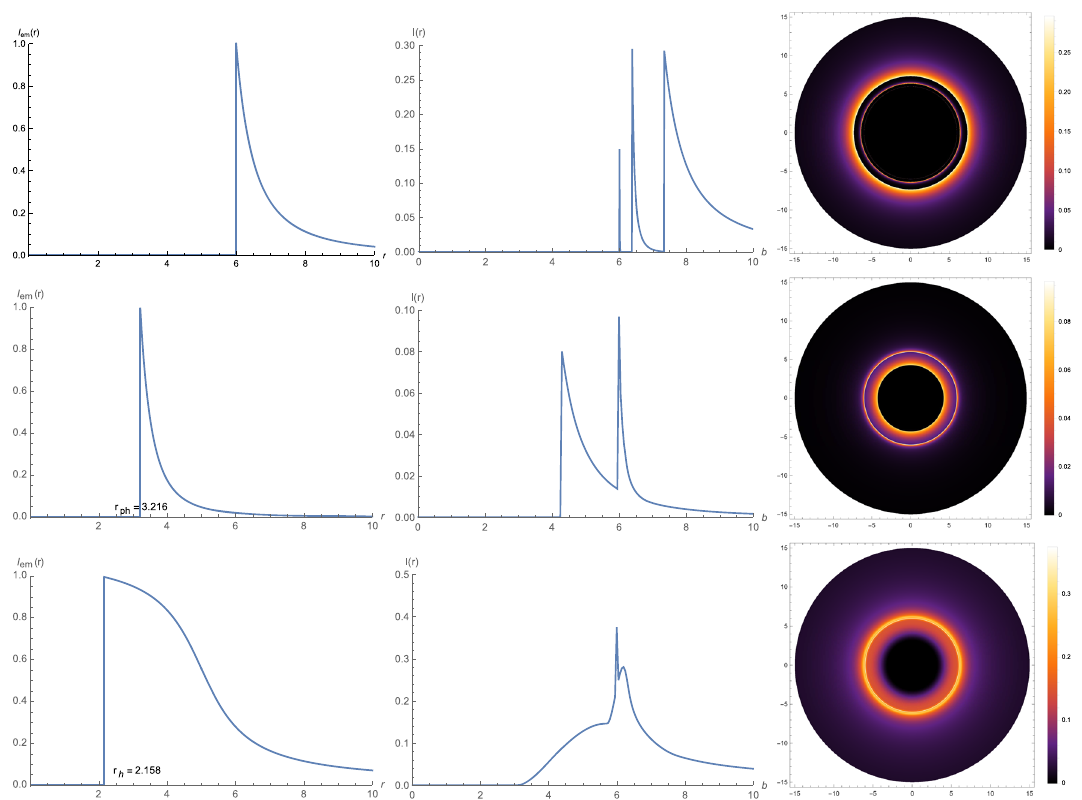
the observed emission I ( r ) as a function of the impact parameter b . The right column shows the two-dimensional density plots of the observed emission I ( r ) . The details can be found in the text